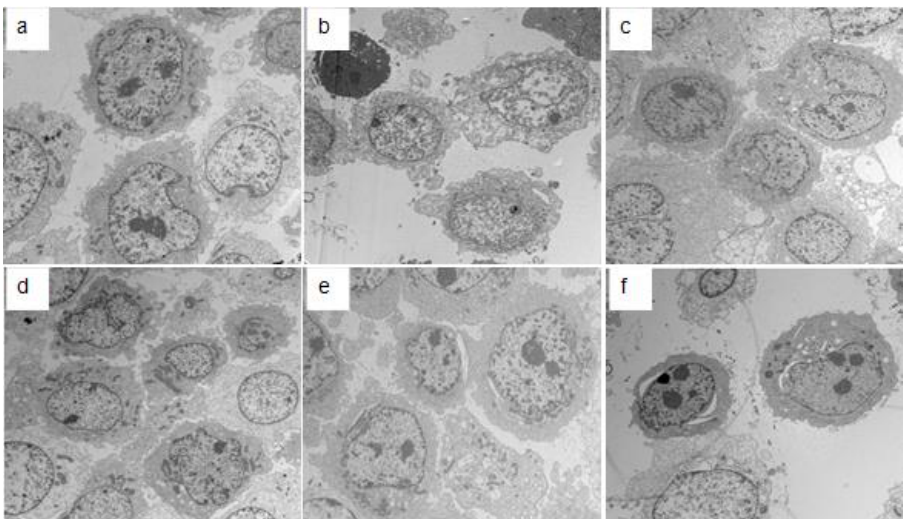
Figure 5. The ultrastructural changes of different stimulation group HMCs under electron microscopy. ( a ) Normal HMCs without stimulation show normal cell morphology; ( b ) HMCs under the stimulation of pIgA1 show smaller cell size, cell shrinkage, and necrosis, and organelle degeneration; ( c ) HMCs under the stimulation of pGSN + PIgA1 show that cell volume increased significantly, with HMCs having a double nucleus, nuclear fission, and cytoplasmic vacuoles; ( d ) HMCs under the stimulation of NIgA1 show individual cells show nuclear sawtooth-like change and the cytoplasm is rich in mitochondria; ( e ) HMCs under the stimulation of pGSN + NIgA1 show the increase of nucleosome and some vacuolar degeneration in the cytoplasm; and ( f ) HMCs under the stimulation of pGSN show cell shrinkage, the increase of nucleosome, and vacuolar degeneration in cytoplasm (electron microscopy, 6000×). Each group contains five samples ( n = 5).